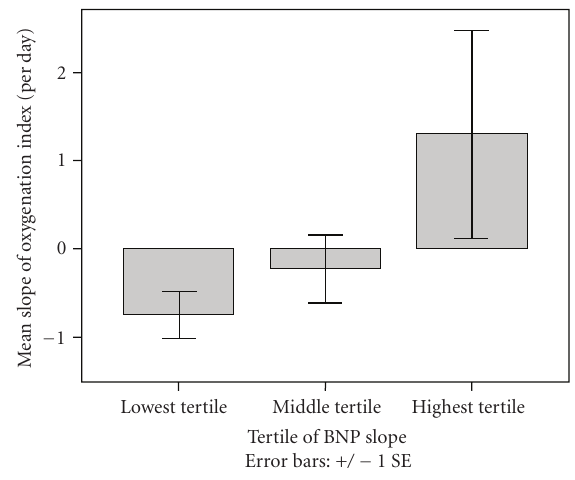
Figure 2: Mean slope of change of Oxygenation Index is shown categorized according to tertile of slope of change of BNP. Absolute di ff erence between highest and lowest tertile 2 . 05 ± 1 . 04, P = . 067 (ANOVA).